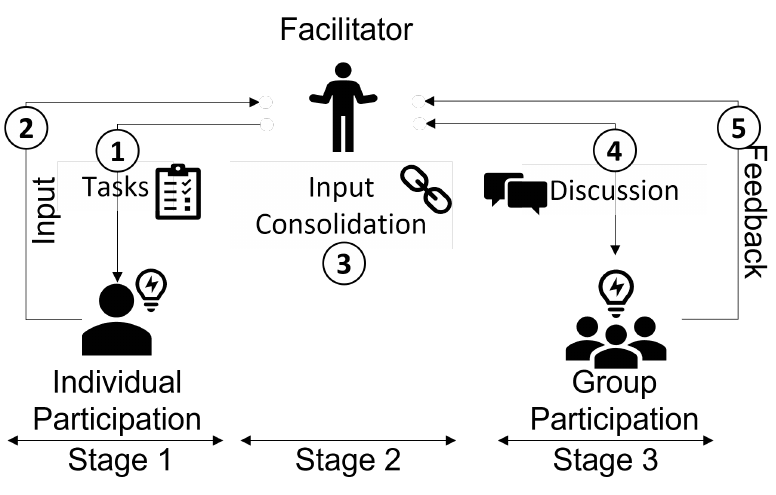
Figure 5. Execution